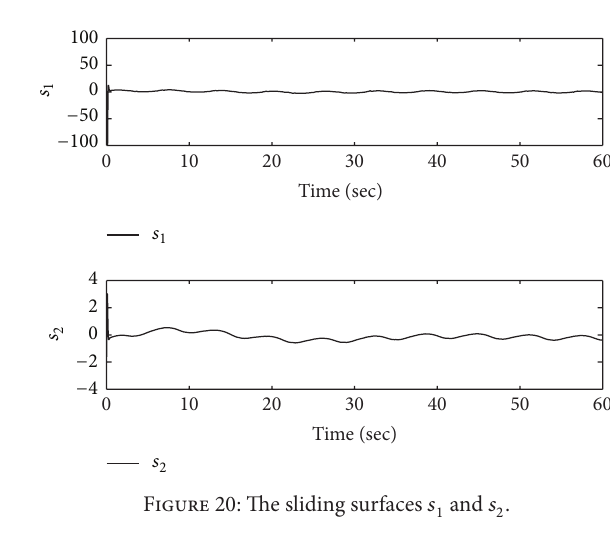
Figure 20: The sliding surfaces 𝑠 1 and 𝑠 2 .